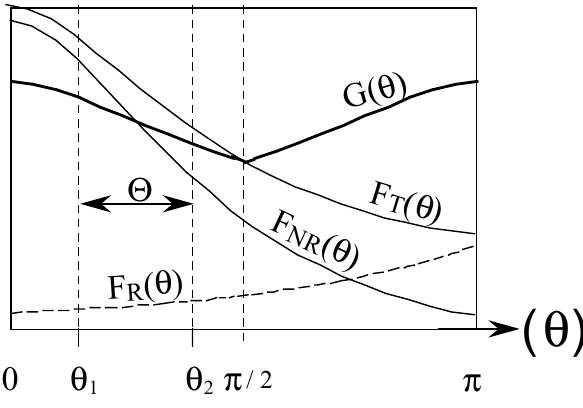
Fig. 5. Schematic differential cross sections for F NR (θ) , F R (θ) ,